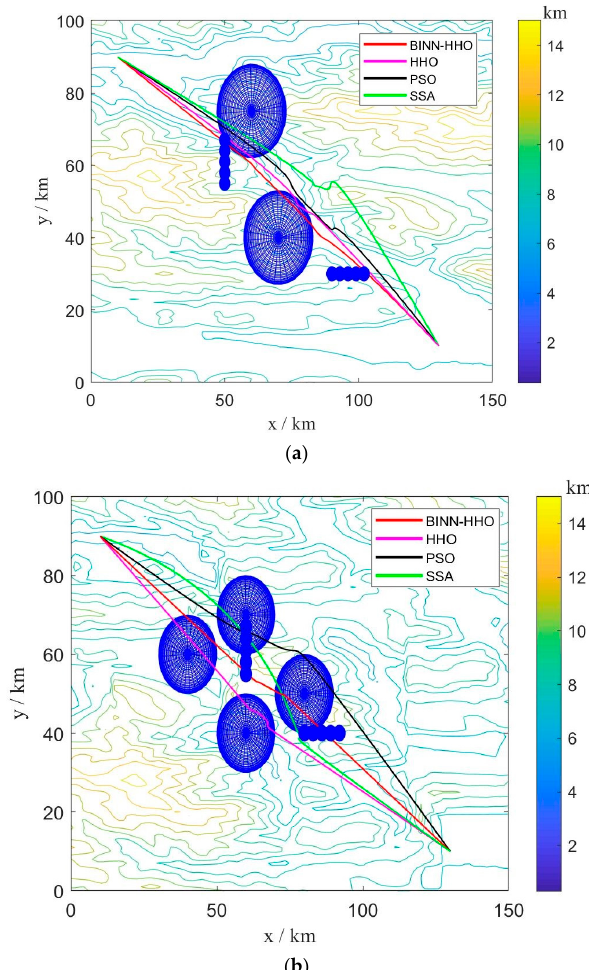
Figure 11. Single-UAV path planning results of BINN-HHO on a 2D simulation map. ( a ) Dynamic case I. ( b ) Dynamic case II.